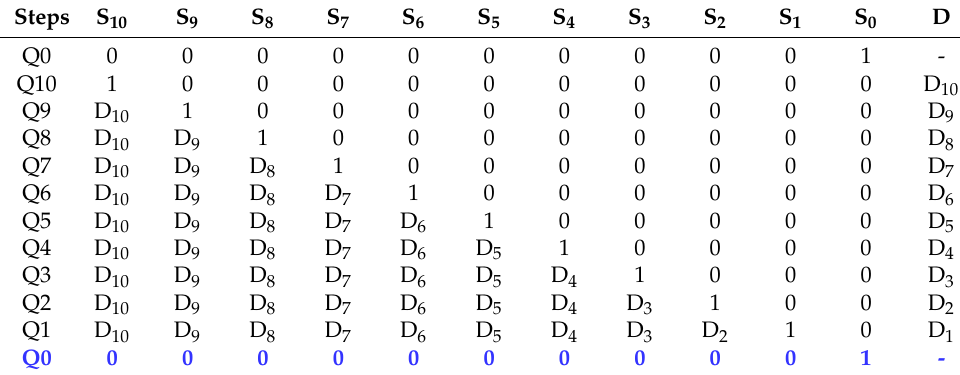
Table 3. State table of DAC switches (S 0 − S 10 ) and output digital codes (D).